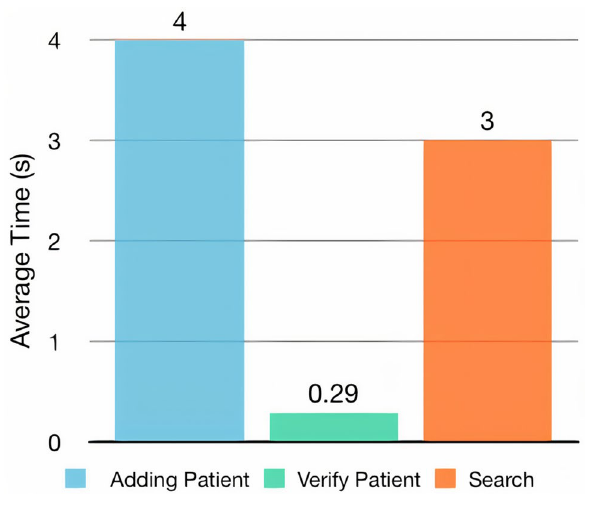
Figure 4. Transaction latency of